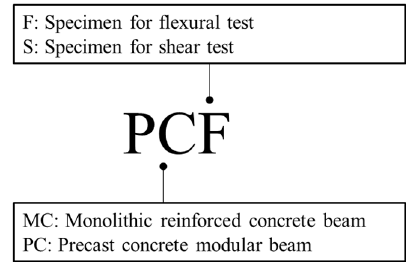
Figure 4. Notation of specimens.